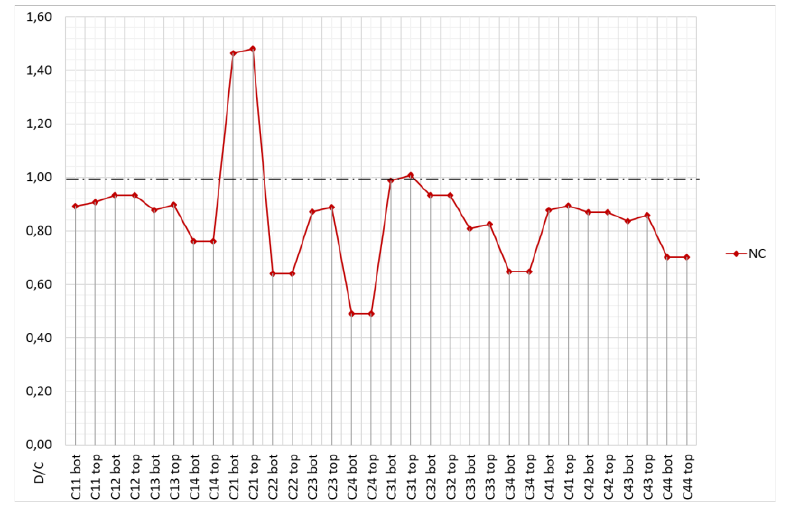
Figure 13. DCM: NC shear force 𝐷 𝐶⁄ ratios on columns (nonlinear dynamic analysis).